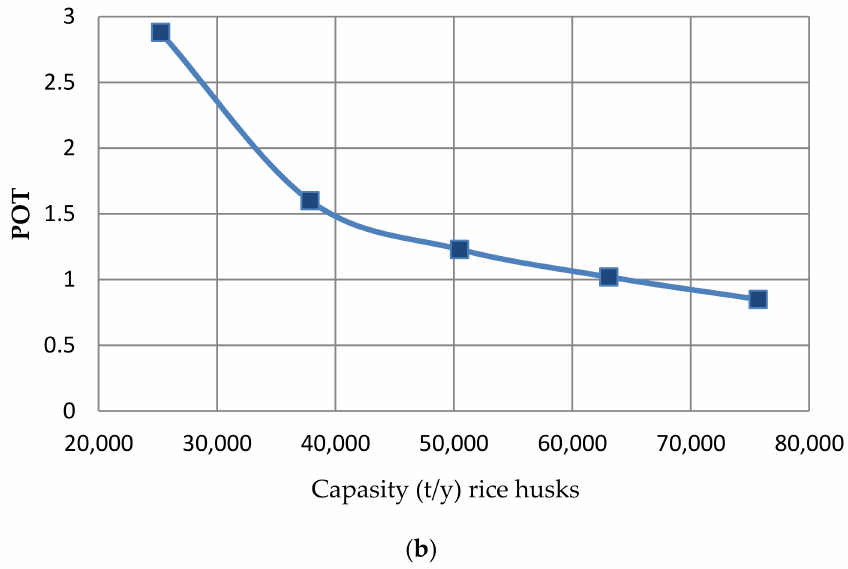
Figure 7. Evolution of the economic indicators ( a ) return of investment (ROI) and ( b ) pay out time (POT) with